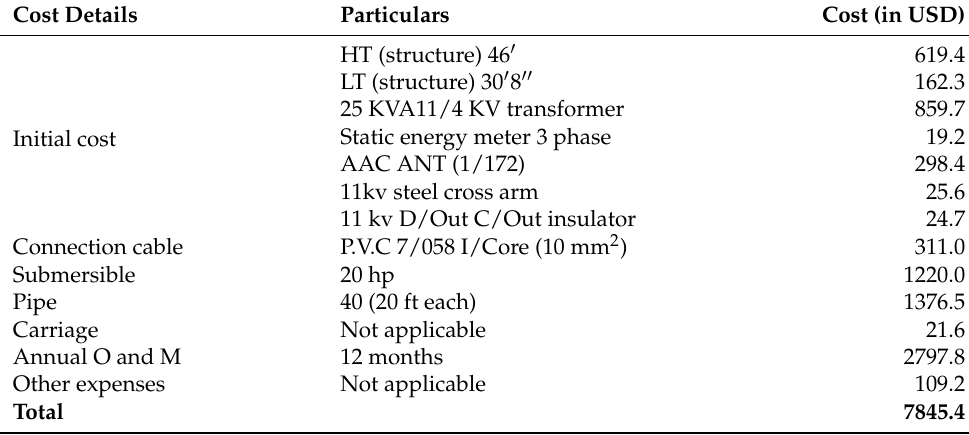
Table 1. Costs related to grid electricity.